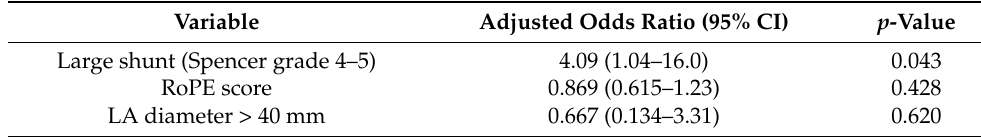
Table 4. Multivariate logistic regression analysis of factors predicting recurrent